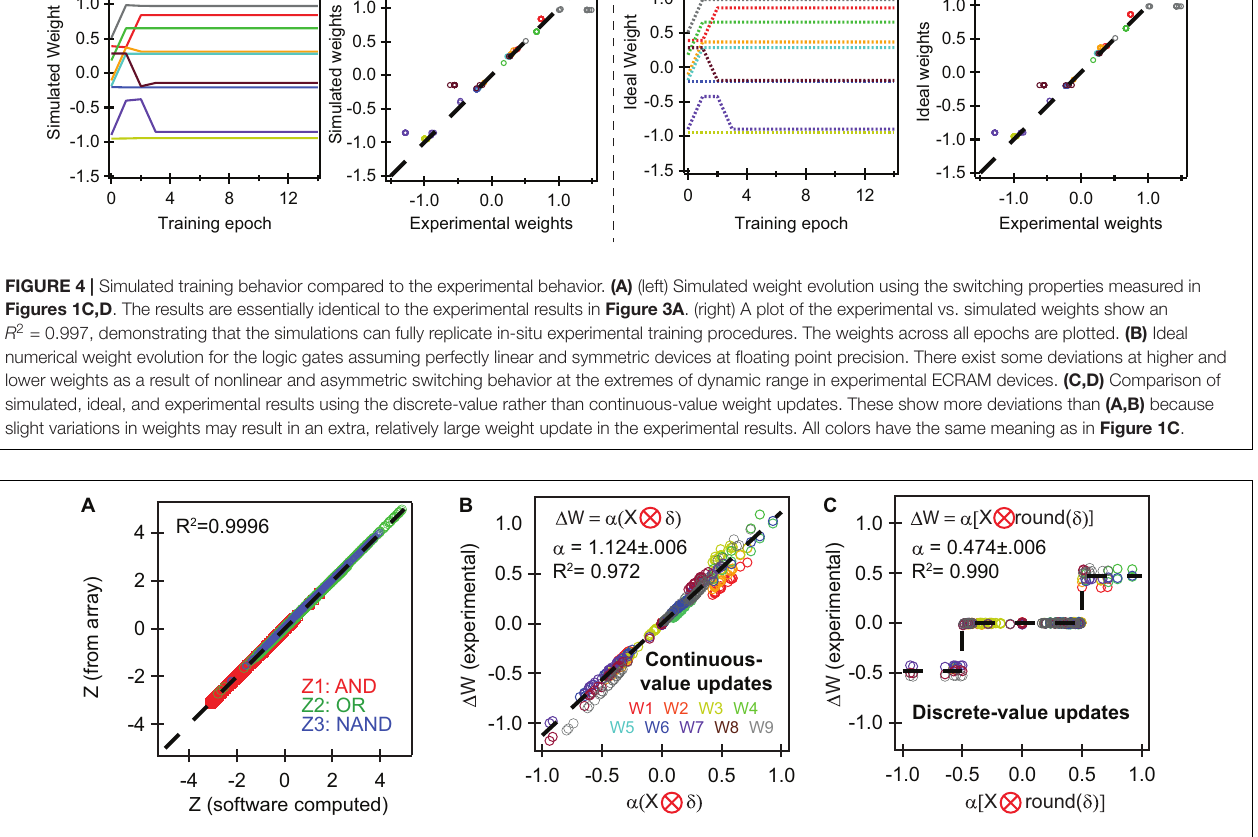
FIGURE 5 | Accuracy of the analog matrix operations. The X axes computes the expected values for the vector matrix multiply and outer product update using software during post-processing. The Y axes plots the obtained value for Z and (cid:49) W experimentally measured from the crossbar. (A) Vector-matrix multiply shows near-perfect agreement. (B,C) Outer product updates are conducted very accurately in accordance with defined cost functions and learning rules, with R 2 over 97%, showing excellent goodness of fit. This result explains the strong convergence between the numerical and experimental results in Figure 4 . The values for α were fit from the experimental vs. simulated outer product